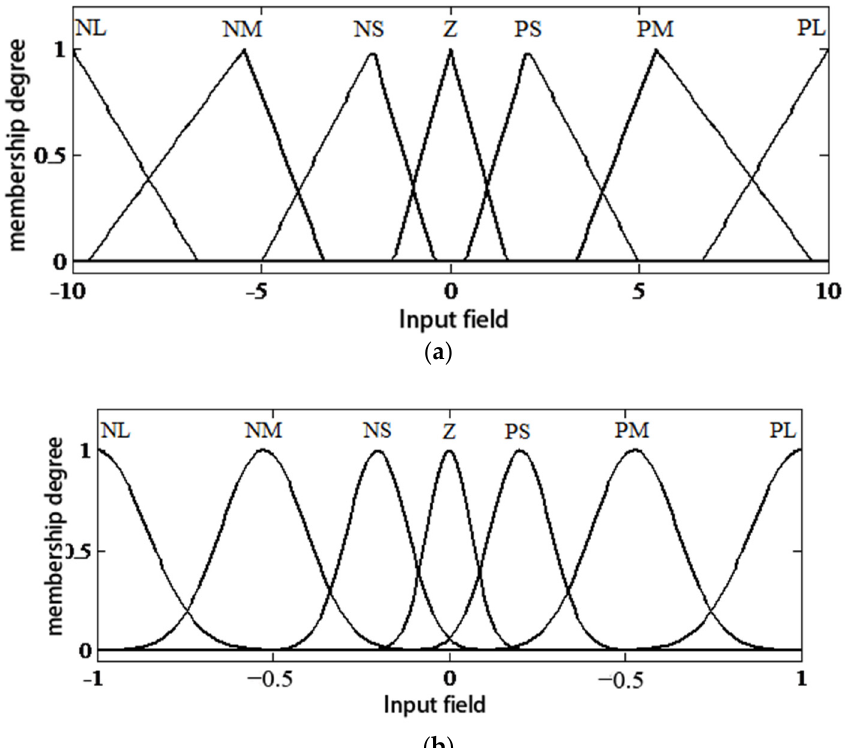
Figure 7. The membership function of input and output. ( a ) Membership functions of input quantities E and EC. ( b ) E, EC membership function of input and output Δ P, Δ membership function of the I. According to the engineering experience, the control rules of the fuzzy controller are formulated. A single fuzzy control rule R i can be expressed as “If (condition 1 AND condition 2), Then (conclusion 1 AND conclusion 2)”. A complete fuzzy controller rule is formed between each rule by the “OR”